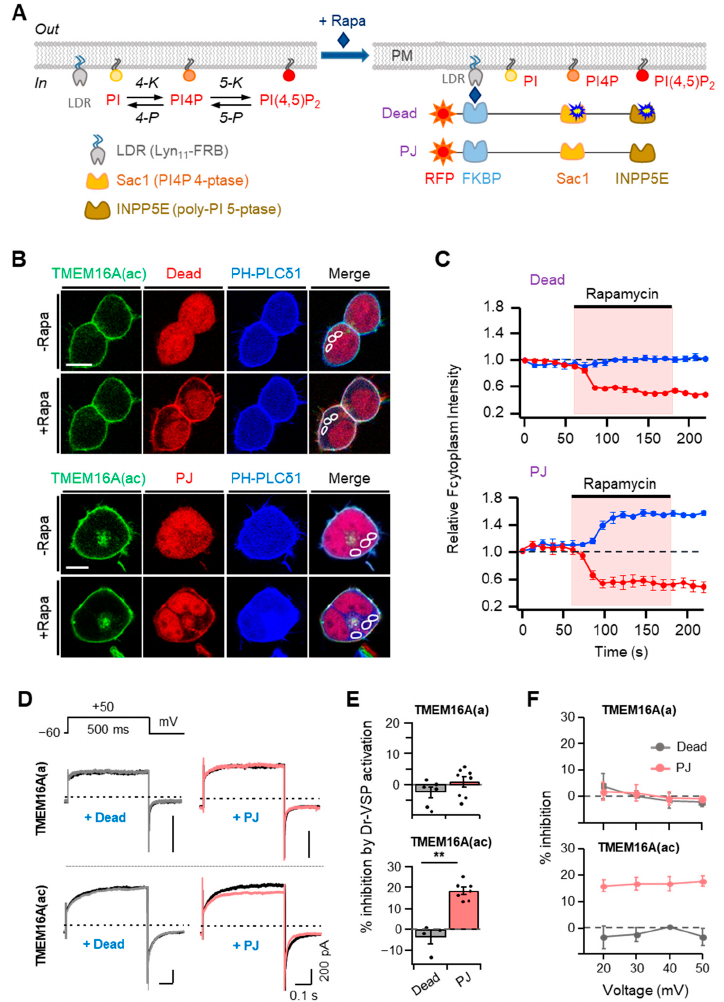
Figure 3. Effects of rapamycin-induced translocation of poly-phosphoinositide phosphatases on TMEM16A currents. ( A ) Left: metabolic pathway of PI(4,5)P 2 synthesis by lipid kinases (4-K and 5-K) and breakdown by lipid phosphatases (4-P and 5-P). PI, phosphatidylinositol; PI4P, phosphatidylinositol 4-phosphate; LDR, Lyn11-FRB; Sac1, PI4P 4-phosphatase; INPP5E, poly-PI 5-phosphatase. Right: schematic diagram showing the rapamycin-induced dimerization of FRB and FKBP proteins. This dimerization leads to the recruitment of poly-PI-metabolizing enzymes to the plasma mem- brane. RF-Dead is a translocatable construct with inactive mutant Sac1 and INPP5E enzymes. ( B ) Confocal images of cells expressing RF-Dead or RF-PJ with GFP-TMEM16A(ac), CFP-PH-PLC δ 1, and LDR. Images were acquired before ( − ) and after (+) the application of rapamycin (1 µ M) for 120 s. Images are representative of three to five cells in three independent experiments. In each cell, three regions of interest were marked in confocal images for the analysis of cytosolic fluorescence intensity in a single cell. The scale bar represents 10 µ m. ( C ) The time course of rapamycin effects on the relative cytosolic fluorescence intensities of CFP-PH-PLC δ 1 (blue) and phosphatase enzymes (red). ( D ) Representative TMEM16A(a) (top) and TMEM16A(ac) (bottom) currents before (black trace) and after (colored trace) the addition of rapamycin (1 µ M) for 1 min in cells co-transfected with LDR and RF-Dead (gray) or RF-PJ (pink). ( E ) Summary of inhibition (%) in TMEM16A(a) and TMEM16A(ac) by rapamycin-induced translocation of RF-Dead or RF-PJ to the plasma membrane (TMEM16A(a): RF-Dead, n = 6, RF-PJ, n = 8; TMEM16A(ac): RF-Dead, n = 4, RF-PJ, n = 6). Dots indicate the individual data points for each cell. Bars indicate means ± SEM. ** p < 0.01 compared with RF-Dead. ( F ) Voltage independence of the rapamycin-induced inhibition of TMEM16A(a) and TMEM16A(ac) channels. The percent inhibition is plotted as a function of the membrane potential